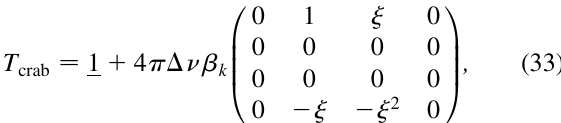
FIG. 6. (Color) Unstable region caused by a crab cavity for (cid:28) close to a half integer with cot (cid:25) Light green: border of stability; dark red: border of stability from the approximate Eq. (cid:2) 1 m (bottom) the (cid:28) (cid:22) k